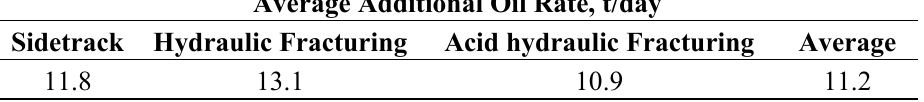
Table 2. Enhanced oil recovery methods efficiency of the east part of the Volga-Ural oil and gas region fields.